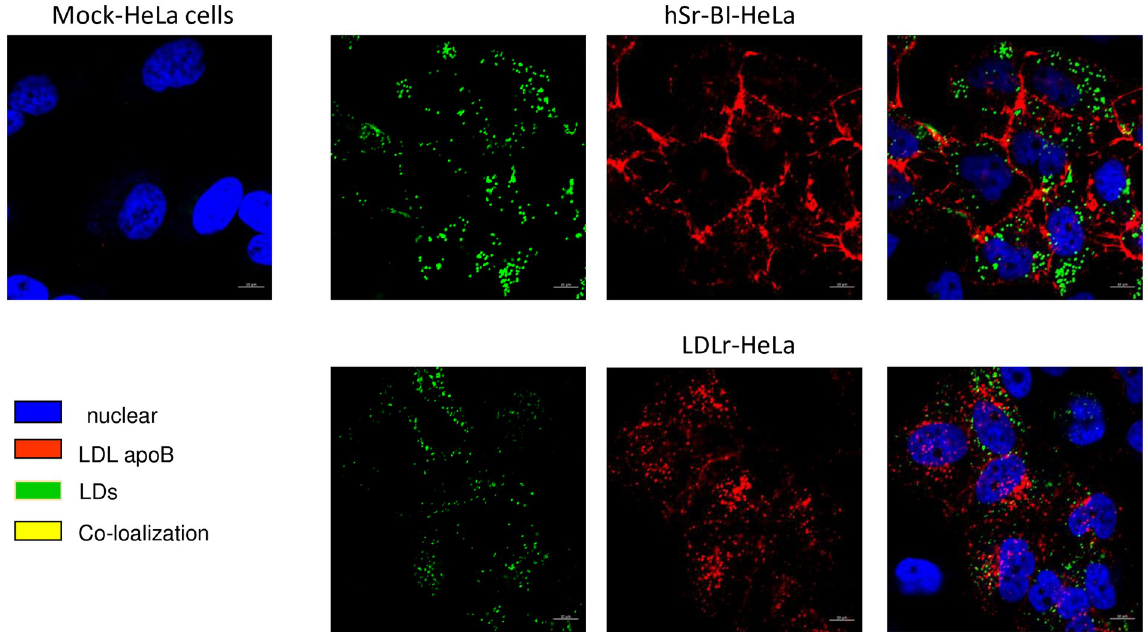
Fig 3. The confocal images of protein labeled LDL in various HeLa cell preparations co-localized with neutral BP-stained LDs. HeLa cells were plated at 30% confluency on glass covered slips and then pre-incubated in serum free media for 24 hours prior to experiments. Labelled LDL were added to the media for 1 hour, washed and chased for 30–60 minutes in serum/lipoprotein free media and stained live with 0.5 μ M of neutral BP for 1 minute. The bar corresponds to 10 μ m.